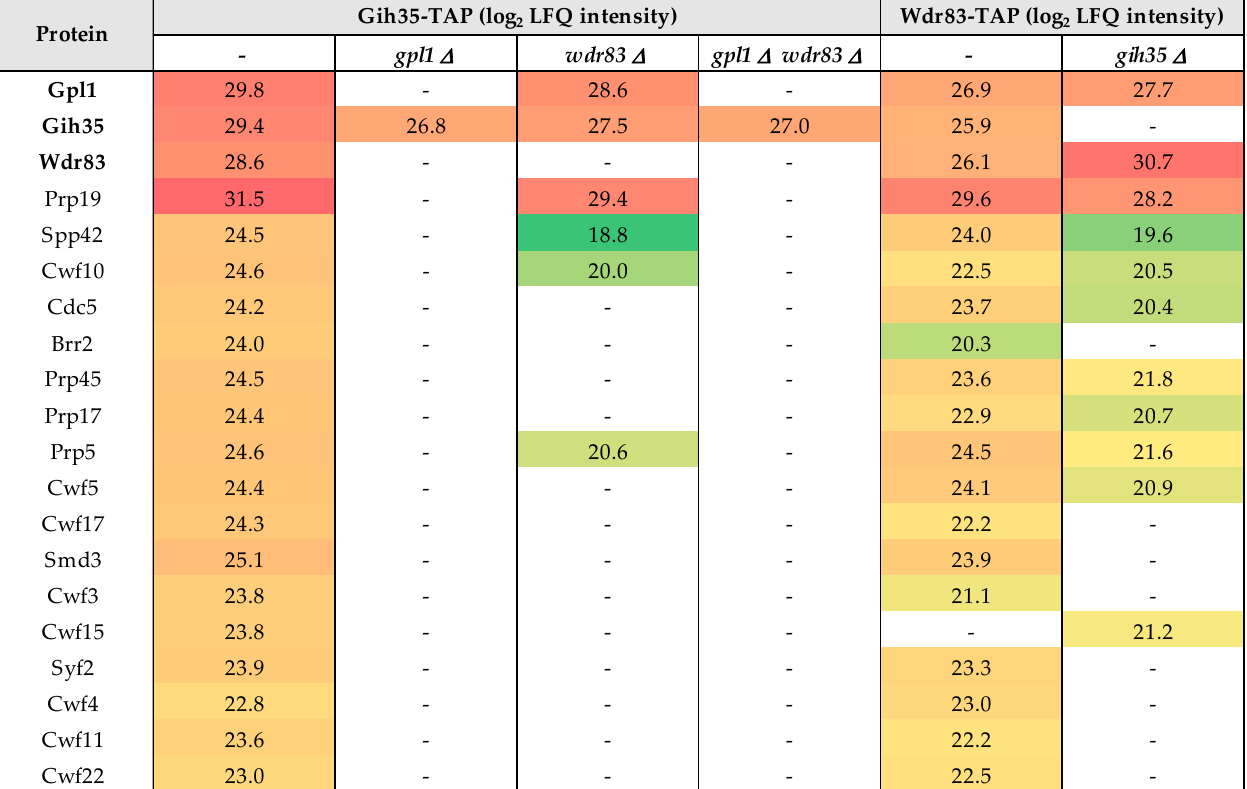
Figure 4. List of selected proteins with determined label-free quantification (LFQ) intensities (see Material and Methods) co-purified with Gih35-TAP and Wdr83-TAP from wild-type cells and indi- cated deletion mutants. For a full list of identified proteins and their post-translational modifications, see Table S2.